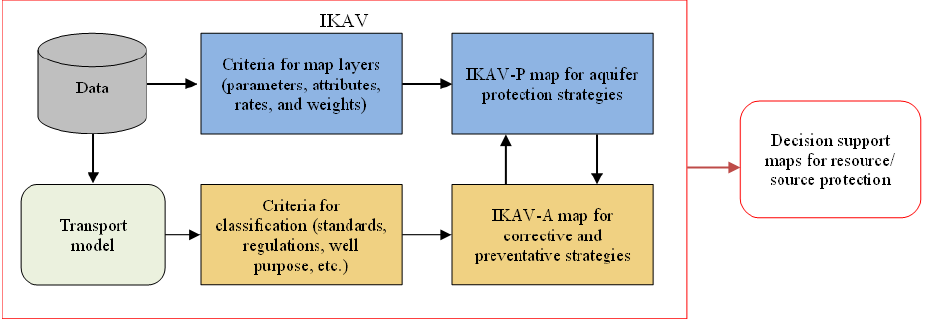
Figure 5. Summarized workflow for the estimation of integrated vulnerability (potential and actual vulnerability). Modified after Moreno- Gómez